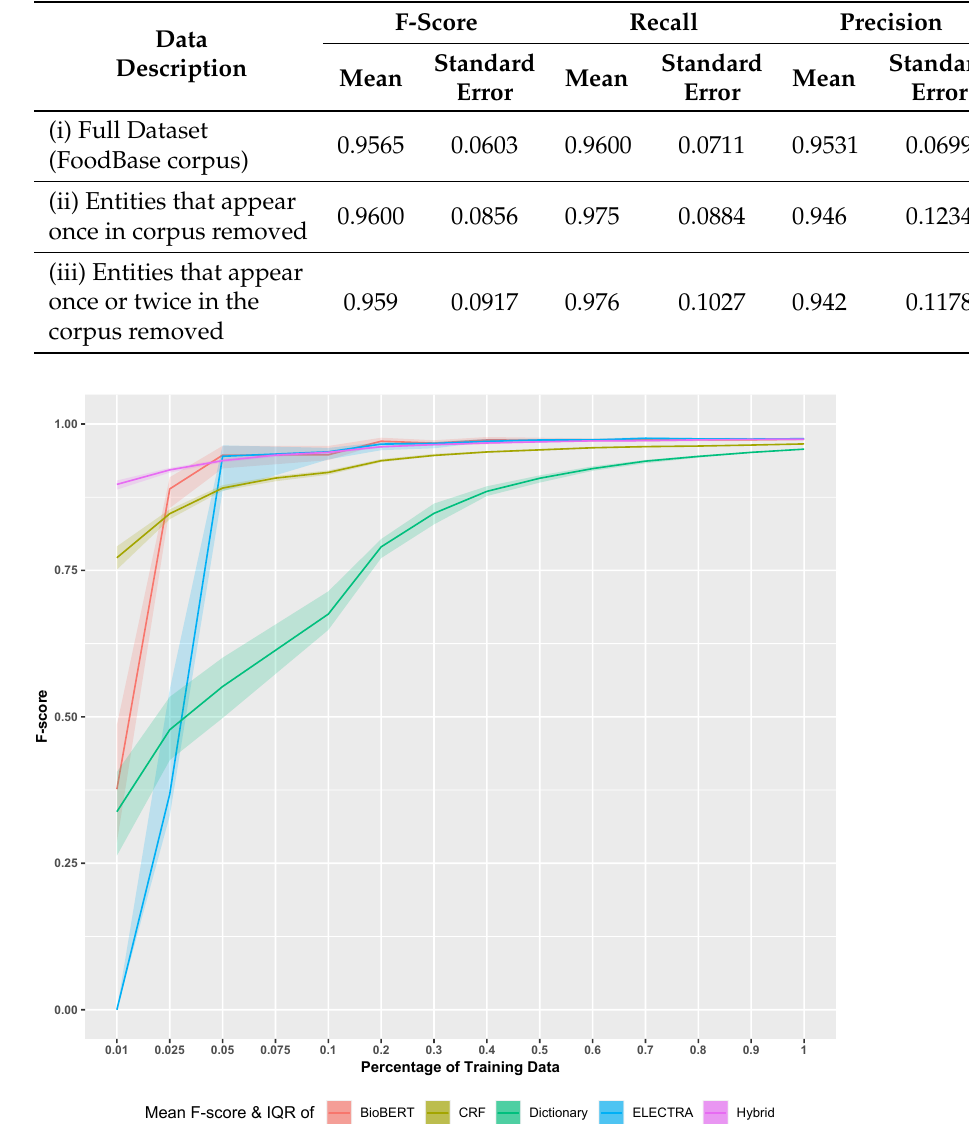
Table 1. Results for the dictionary-based model evaluated with 10-fold CV. The rows correspond to three different data sets: (i) full dataset (corresponding to the FoodBase corpus), (ii) data where entities have been removed that appear just once and (iii) data where entities have been removed that appear just once or twice.